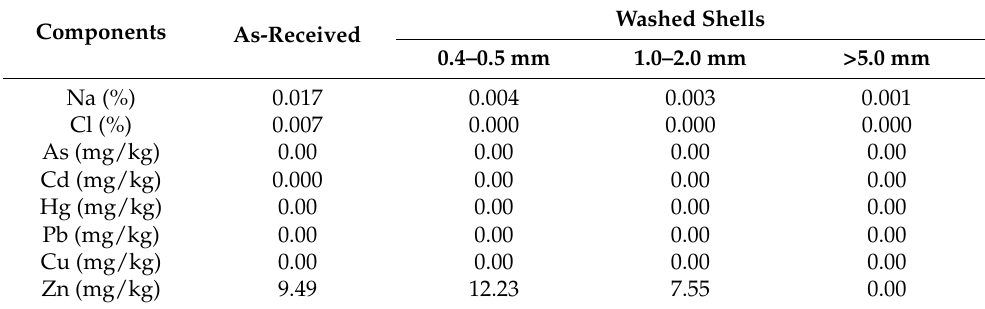
Table 4. NOSs and washed NOS components under different particle size by elution